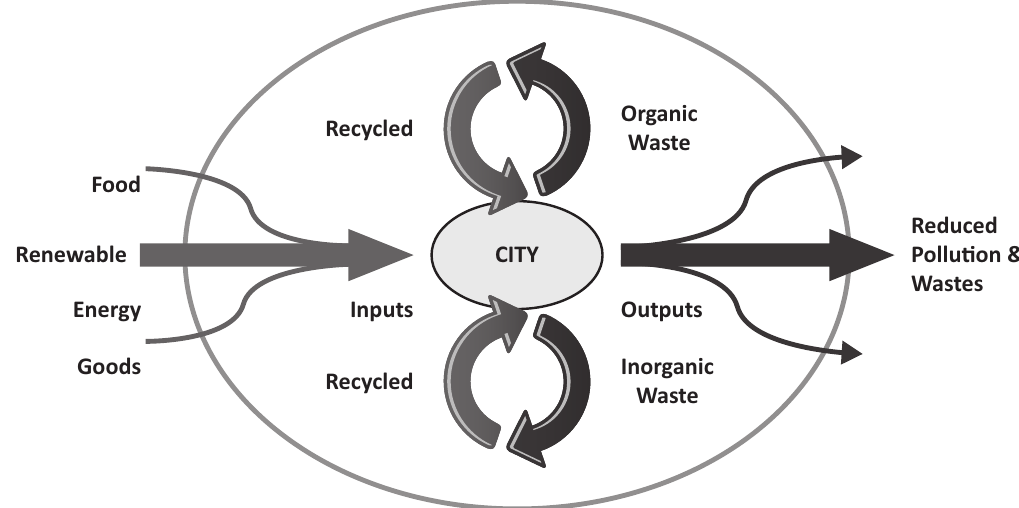
Figure 2. Circular metabolisms (Newman et al., 2017) adapted from Rodgers (1997).